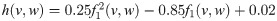
Results from reconstructing the state of a noise driven Fitzhugh-Nagumo system with large observation function error.Reconstruction results for the (a) v and (b) w system variables (solid black lines denote true trajectories) given the noisy observations (solid blue circles). The large error between the filter observation function in Eq 10 and the unknown true observation function, h(v,w)=0.25f12(v,w)-0.85f1(v,w)+0.02, causes the standard filter (solid gray line) to fail in tracking the system dynamics (RMSE = 0.95, 0.53 for v and w respectively). The bias-corrected filter (solid red line) significantly improves on the state reconstruction (RMSE = 0.26, 0.12 for v and w respectively).